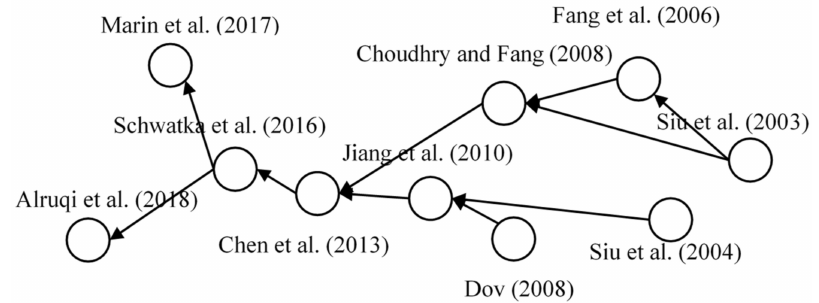
Figure 9. Main path of safety